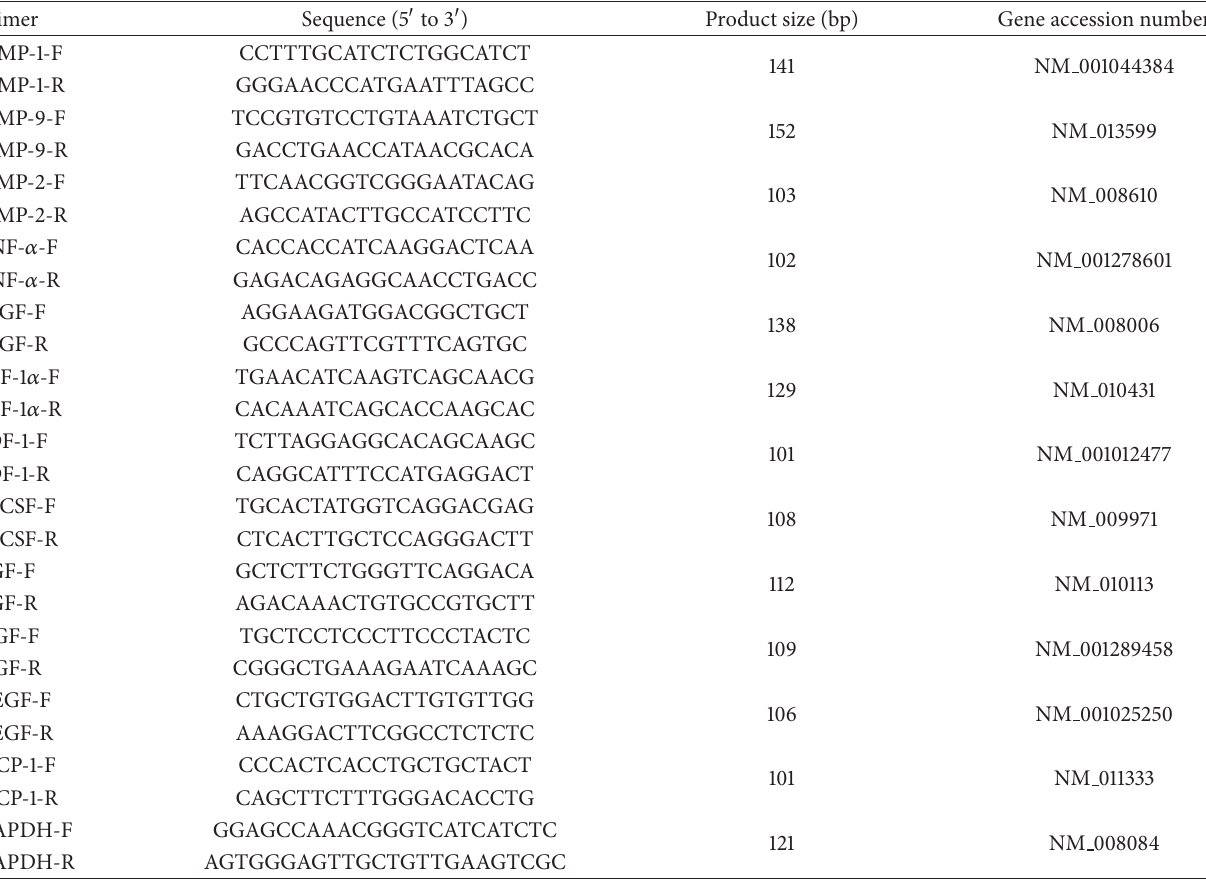
Table 1: Primer sequences in qPCR assay.